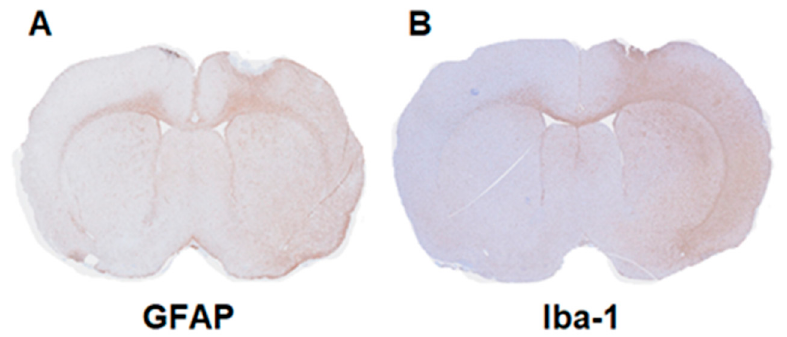
Figure 6. Immunohistochemical staining for the presence of microglia and astrocytes in unilateral lipopolysaccharide (LPS)-injected male rat brains. ( A ) Glial fibrillary acidic protein (GFAP, activated astrocytes) and ( B ) ionized calcium binding adaptor molecule 1 (Iba-1, microglia/macrophages) of an LPS-injected male rat brain at 7 days post-LPS injection in the right striatum.